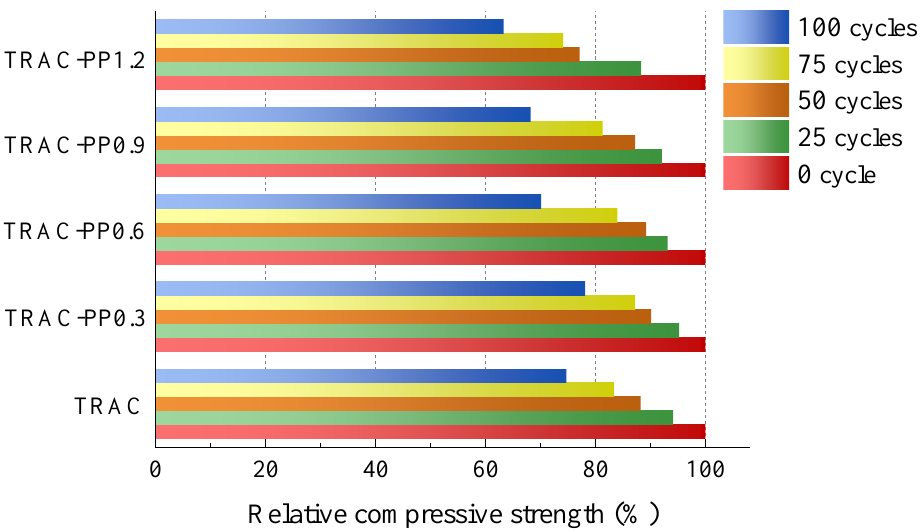
Figure 11. Relative compressive strength of all mixtures during freeze – thaw cycles.